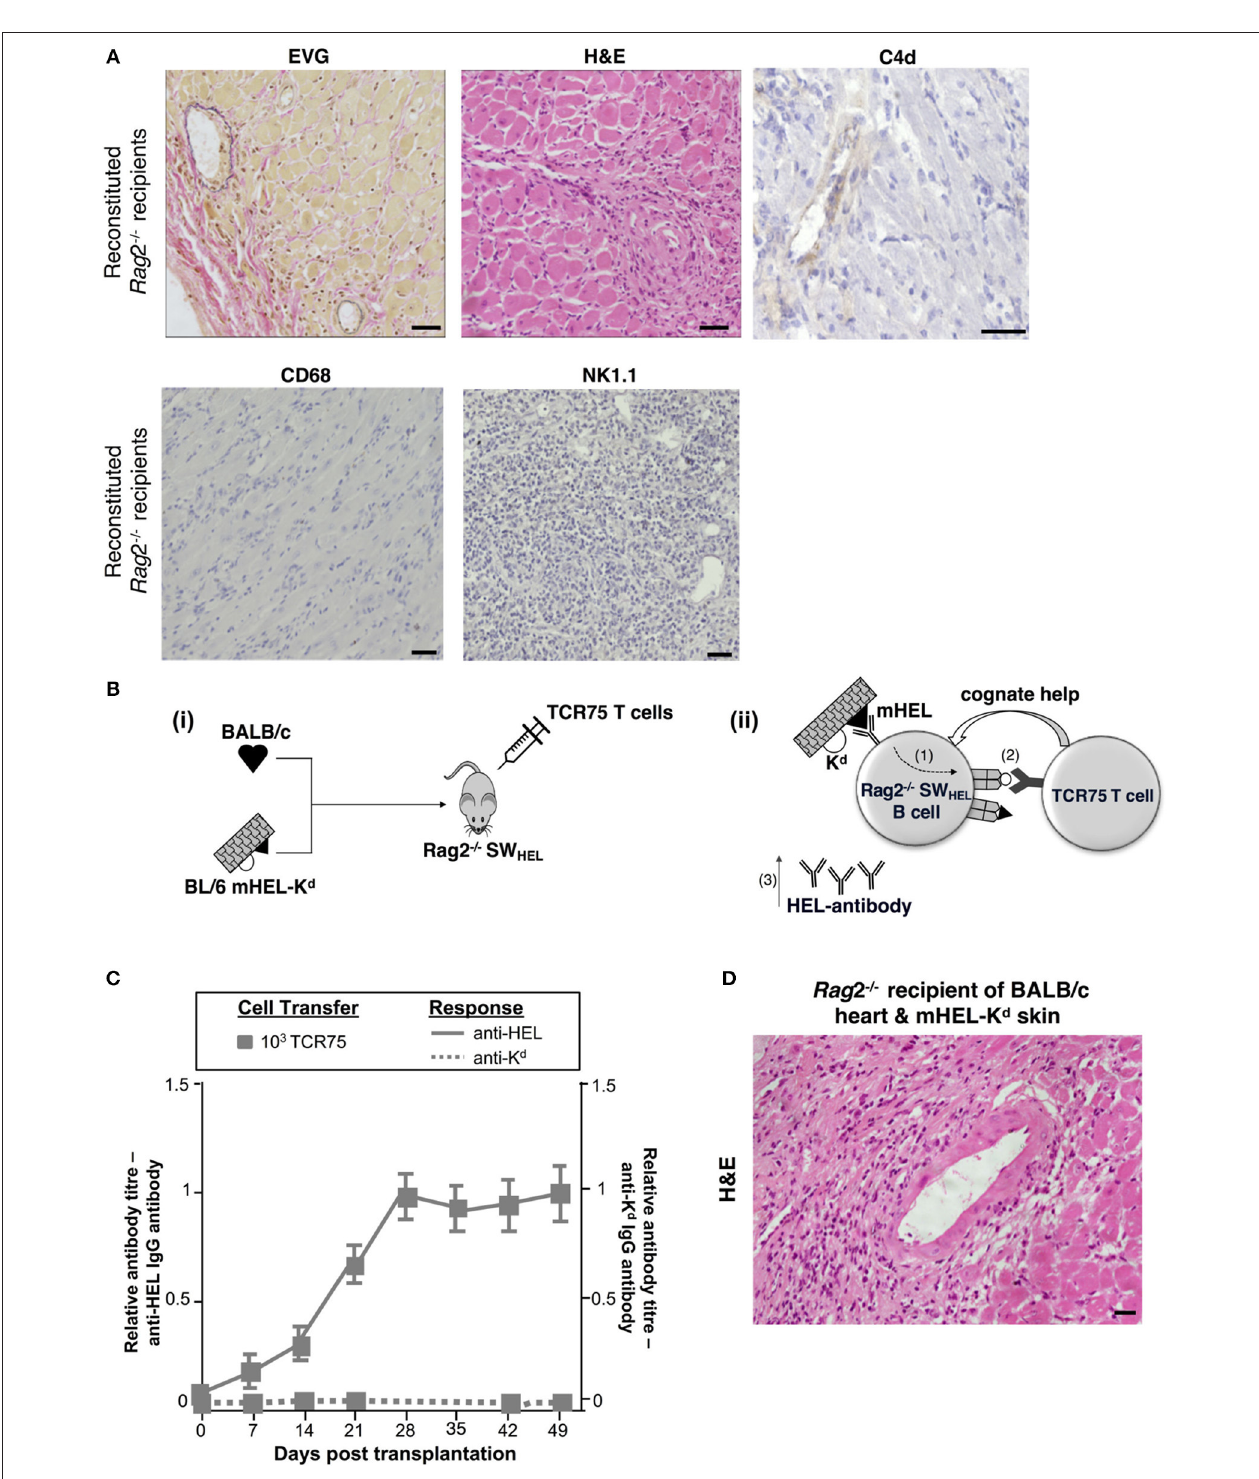
FIGURE 6 | Contribution of alloantibody to allograft rejection. (A) Elastin van Gieson and H&E stained sections of d50 BALB/c heart allografts from reconstituted Rag2 − / − recipients with 10 3 TCR75 CD4T cells demonstrate focal areas of mild concentric vasculopathy and lymphocytic infiltrates (EVG) within well-preserved vasculature and myocardium ( H&E), with absence of capillary C4d staining and NK cell and macrophage infiltration. Scale bars: H&E, CD68, and NK1.1–50 µ m; EVG − 65 µ m; C4d − 100 µ m. (B) Model to distinguish alloantibody production from alloantigen presentation. (i) BALB/c heart graft and BL/6 mHEL-K d skin graft which co-express membrane-bound Hen Egg Lysosyme (HEL, black triangle) and MHC class I H-2K d (white semicircle) were engrafted to a Rag2 − / − SW HEL recipient,